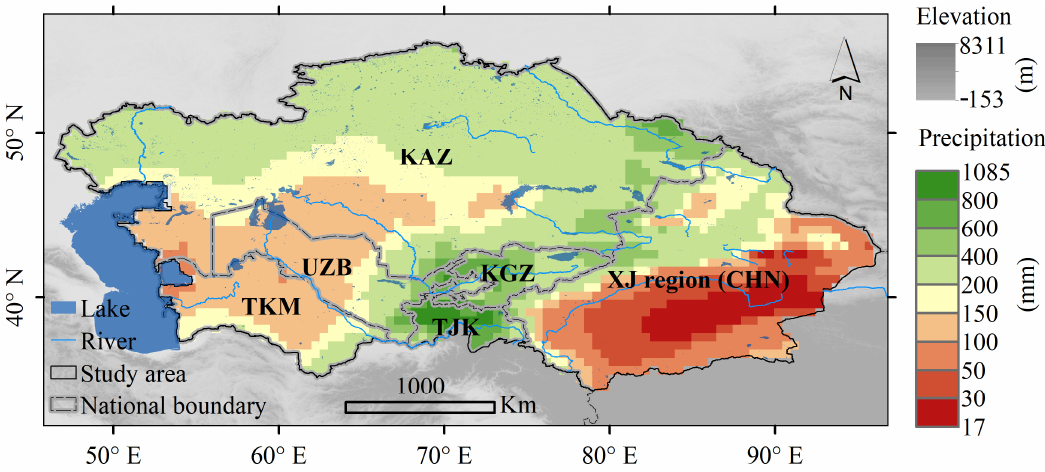
Figure 1. Basic geographic and precipitation information of the arid Central Asia.